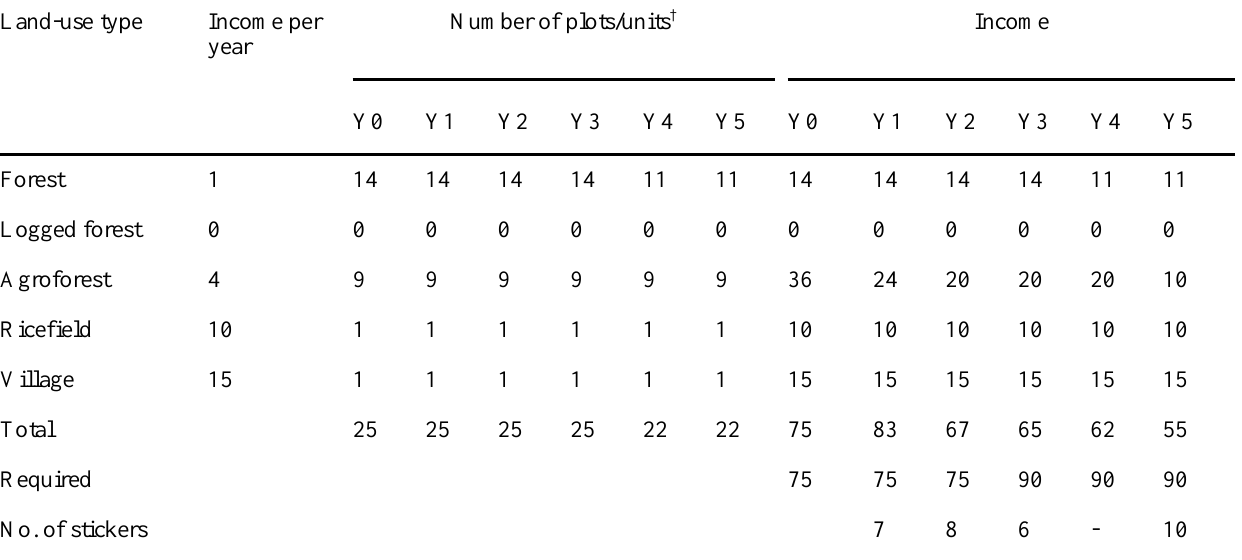
Table 3. Sample score sheet for each village group Land-use type Income per